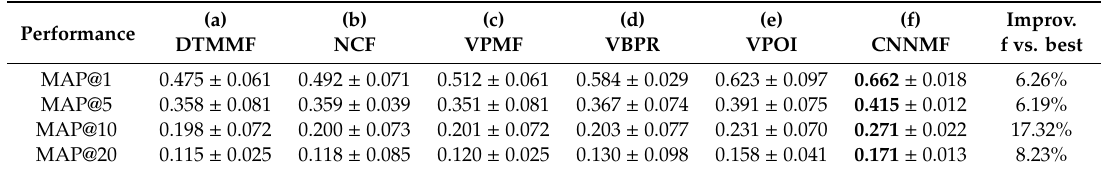
Table 4. The performance comparison of recommendation methods (results indicated as (mean ± standard deviation)) in terms of MAP@n.